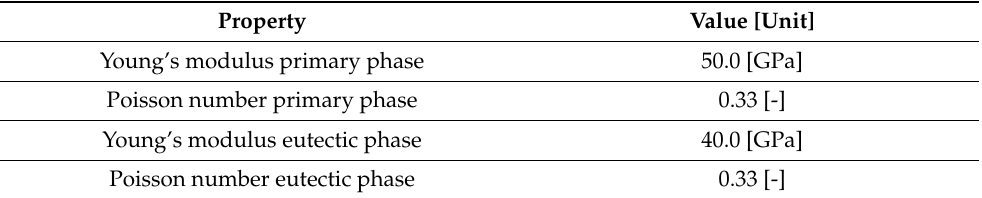
Table 2. Elastic material parameters of RVE-FE model [17].